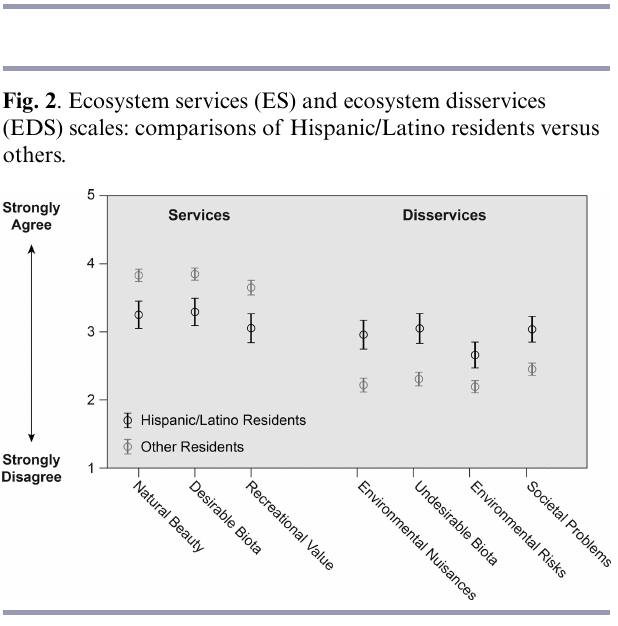
Table 4 . Statistics for composite scales. Ecosystem services (ES); ecosystem disservices (EDS).